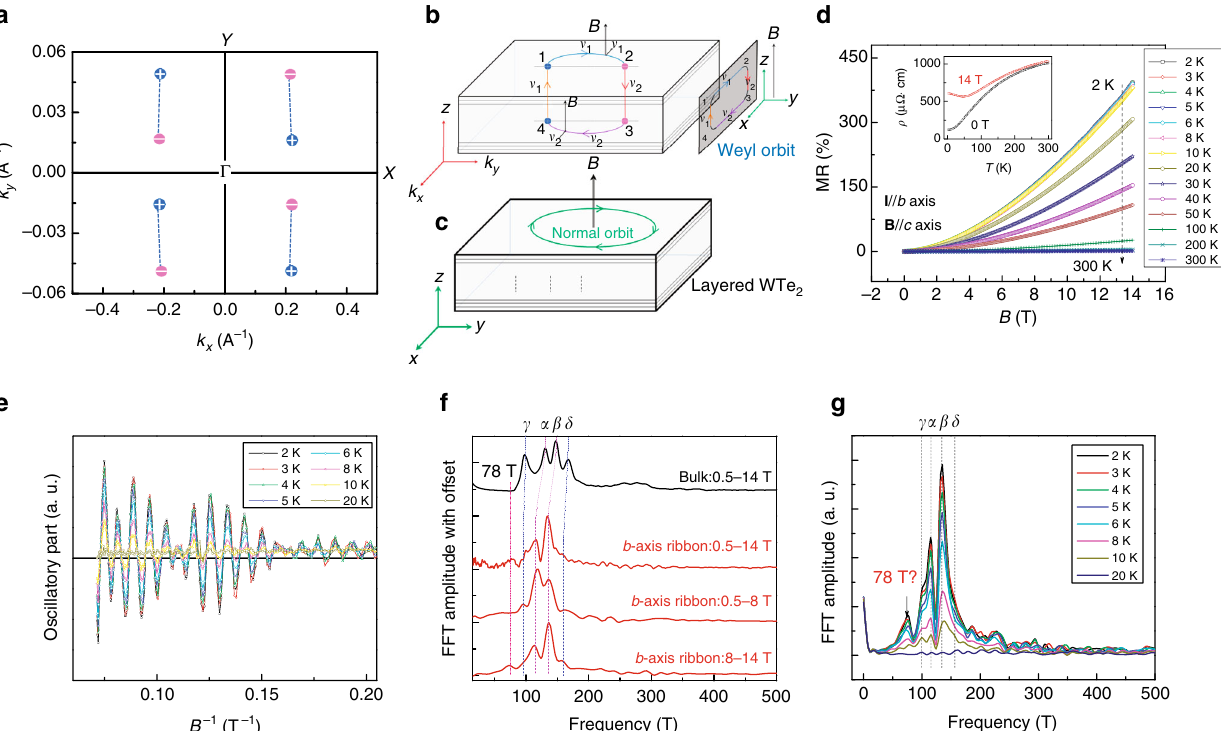
Fig. 1 Fermi-arc-induced Weyl orbit oscillations. a The calculated Weyl points and a possible Fermi arc in the k z = 0 plane of WTe 2 6,13 . The Fermi arcs are mainly along Y direction. b Schematic of a Fermi-arc-induced Weyl orbit in a thin WTe 2 nanoribbon, in which the magnetic fi eld is along the z -axis (or c -) axis. This schematic is similar to that proposed by Potter et al. 19 . This Weyl orbit is formed by connecting two bulk paths along the z -direction through the zeroth chiral bulk Landau level (LL) and two Fermi arcs in the momentum space, on both the top and bottom surfaces. The trajectory of the Weyl orbit in real space is in the xz plane, and the Weyl orbit is plotted in a combination of real space and momentum space. The Weyl points with opposite chirality are labeled as + (blue) and – (purple). c Conventional quantum oscillation orbit. d MR of the b -axis ribbon (19.4 nm thick) at different temperatures with B // c . Inset shows a metal – insulator transition under a magnetic fi eld of 14 T. e The pronounced SdH oscillations are observed at different temperatures in the plots of d 2 R /d B 2 vs. B . f Comparison of FFT of the data of d 2 R /d B 2 vs. B obtained from bulk WTe 2 and b -axis ribbon ( T = 2 K). The FFT data obtained from d 2 R /d B 2 vs. B for B > 8.0 T shows an extra frequency of 78 T. g The FFT spectra of b -axis ribbon at different